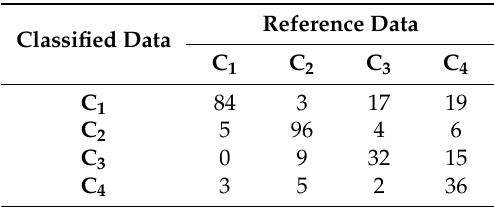
Table 5. Confusion matrix